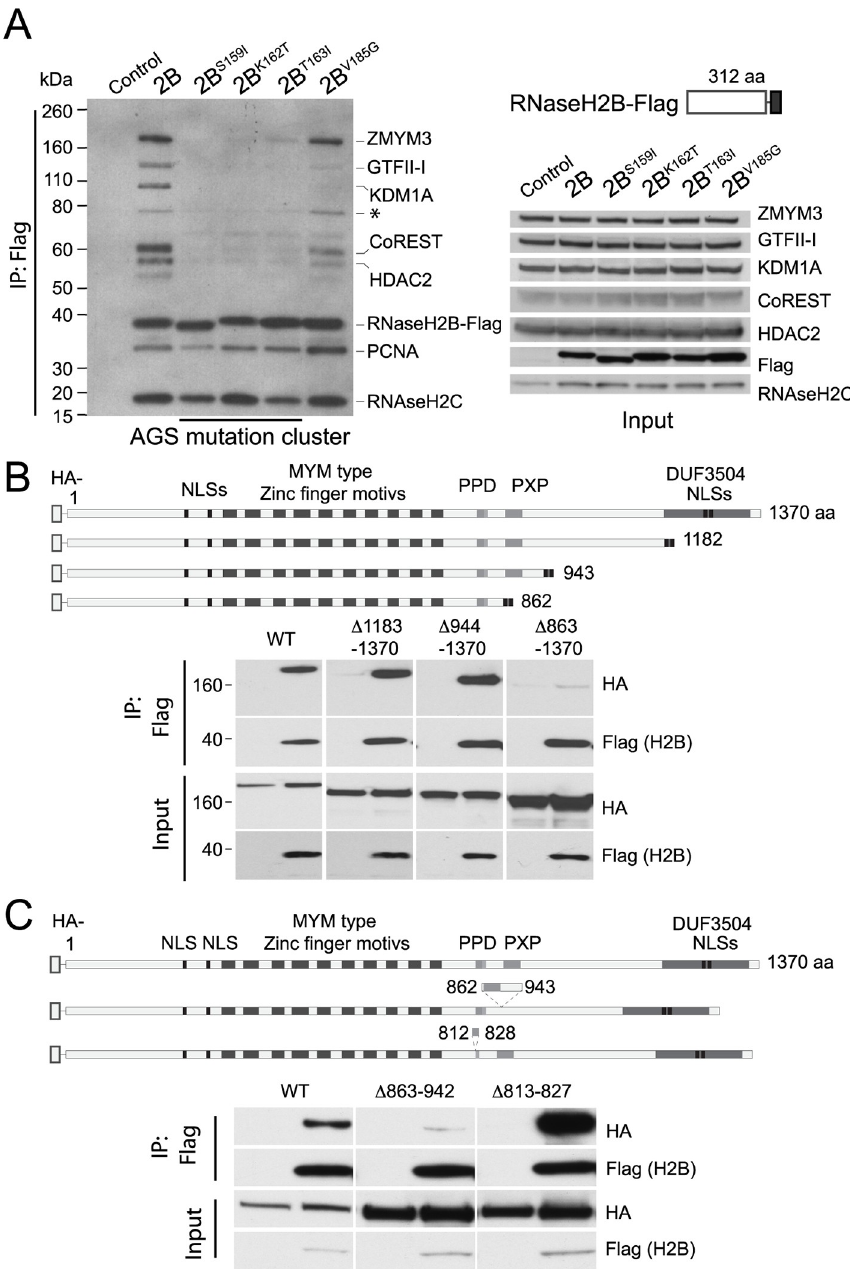
Fig 2. RNase H2 interaction with ZMYM3 and CoREST is mediated the proline rich region. (A) ZMYM3 and RNase H2B are associated as part of the larger CoREST complex. Transfected FLAG-RNase H2B pull downs in HEK293T cell extracts brings down ZMYM3 and CoREST, but both are lost or partially lost in mutants S159I, K162T and T163. On the left, individual developed films are shown as an overlap to allow comparison of the different protein sizes. The input on the right (~3% of the lysates) is shown for the endogenous RNase H and members of the CoREST complex as well as the Flag-RNase H2B transfected protein. Antibodies used for western blotting were Rabbit anti- ZMYM3, Mouse anti-FLAG M2 Peroxidase, Rabbit anti-RNase H2C, Rabbit anti-GFII-I, Rabbit anti-CoREST, Rabbit anti-HDAC2, Goat anti-Rabbit IgG Peroxidase and Goat anti-Mouse IgG Peroxidase. The � indicates an isoform of GTFII-I. The same result was observed in four independent pull-downs. (B) HA-tagged ZMYM3 protein fragments in HEK293T cell extracts co-immunoprecipitated with FLAG-tagged RNase H2B. The schematic shows the domain architecture of ZMYM3 and the C-terminally truncated fragments, including the nuclear localisation region from the DUF3504 domain (black). The first and last amino acids of full and truncation proteins are indicated according to full- length human ZMYM3 (UniProtKB: Q14202.2). PPD: Proline-rich region. NLS: Nuclear localisation signal. Each